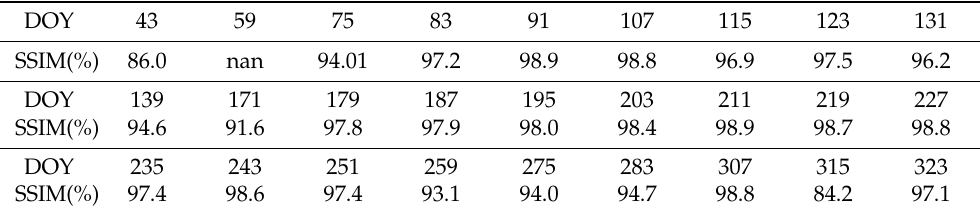
Table 6. Structural similarity measure (SSIM) between input and output NDVI images for the NRM area.